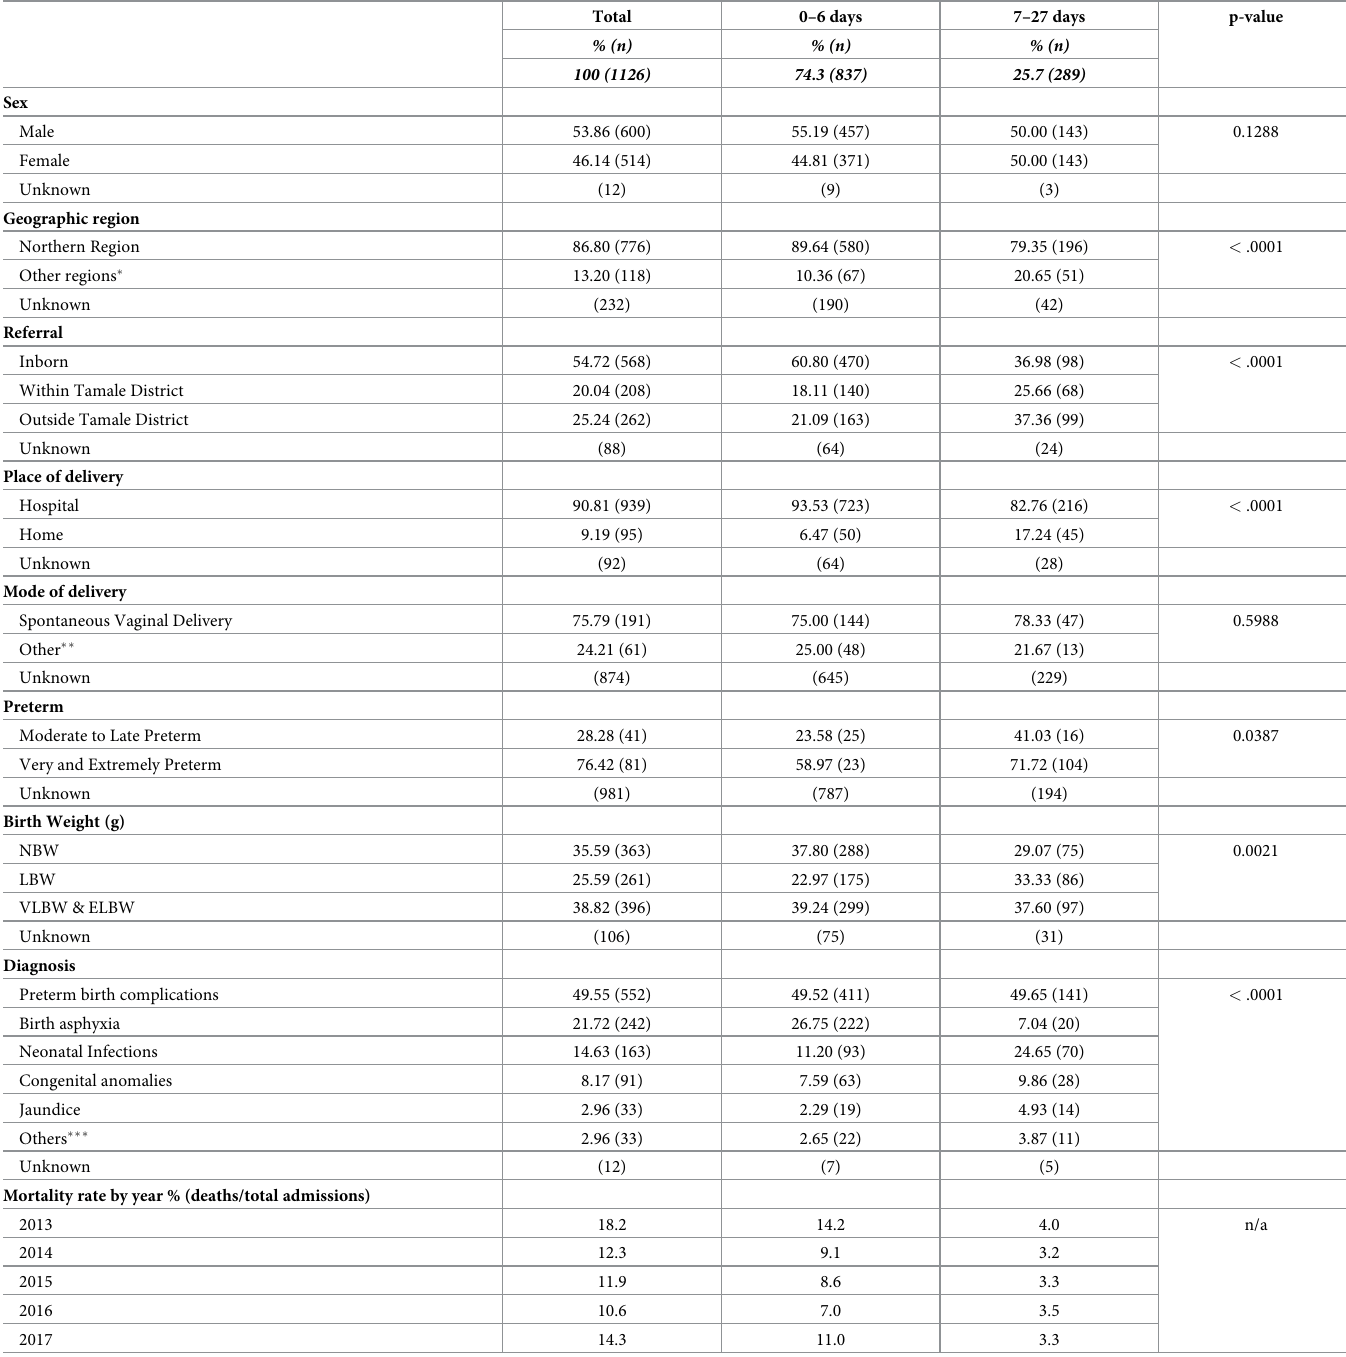
Table 1. Demographic characteristics of neonatal deaths in NICU at Tamale Teaching